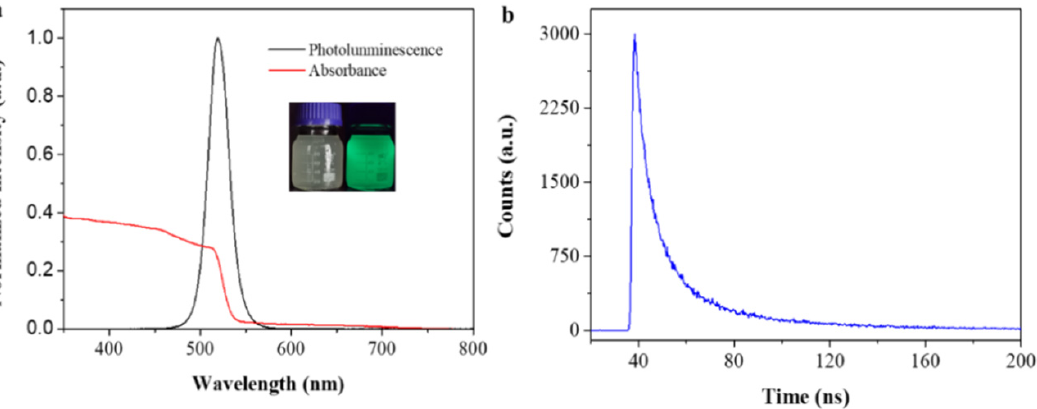
Figure 5. ( a ) Absorption (red line) and PL (black line) spectra of CsPbBr 3 @SiO 2 PNCCs with a PL maximum at 513 nm, FWHM of 22 nm and PLQY of 60% (inset photograph of CsPbBr 3 @SiO 2 PNCCs in ethanol solution under ( left ) normal white light and ( right ) a UV lamp with λ of 365 nm); ( b ) time-resolved photoluminescence decay of CsPbBr 3 @SiO 2 PNCCs.